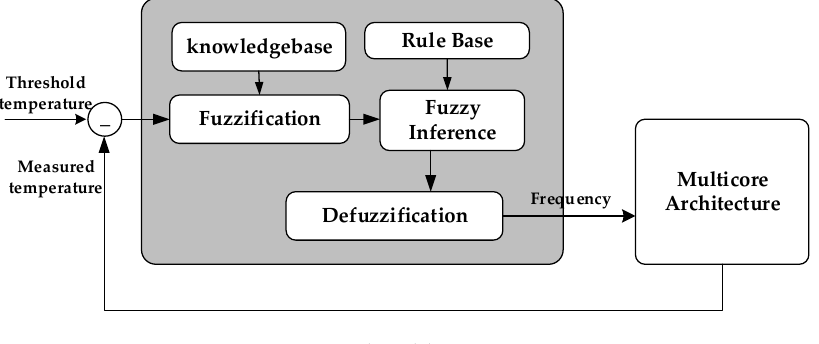
Figure 4. Closed-loop system.